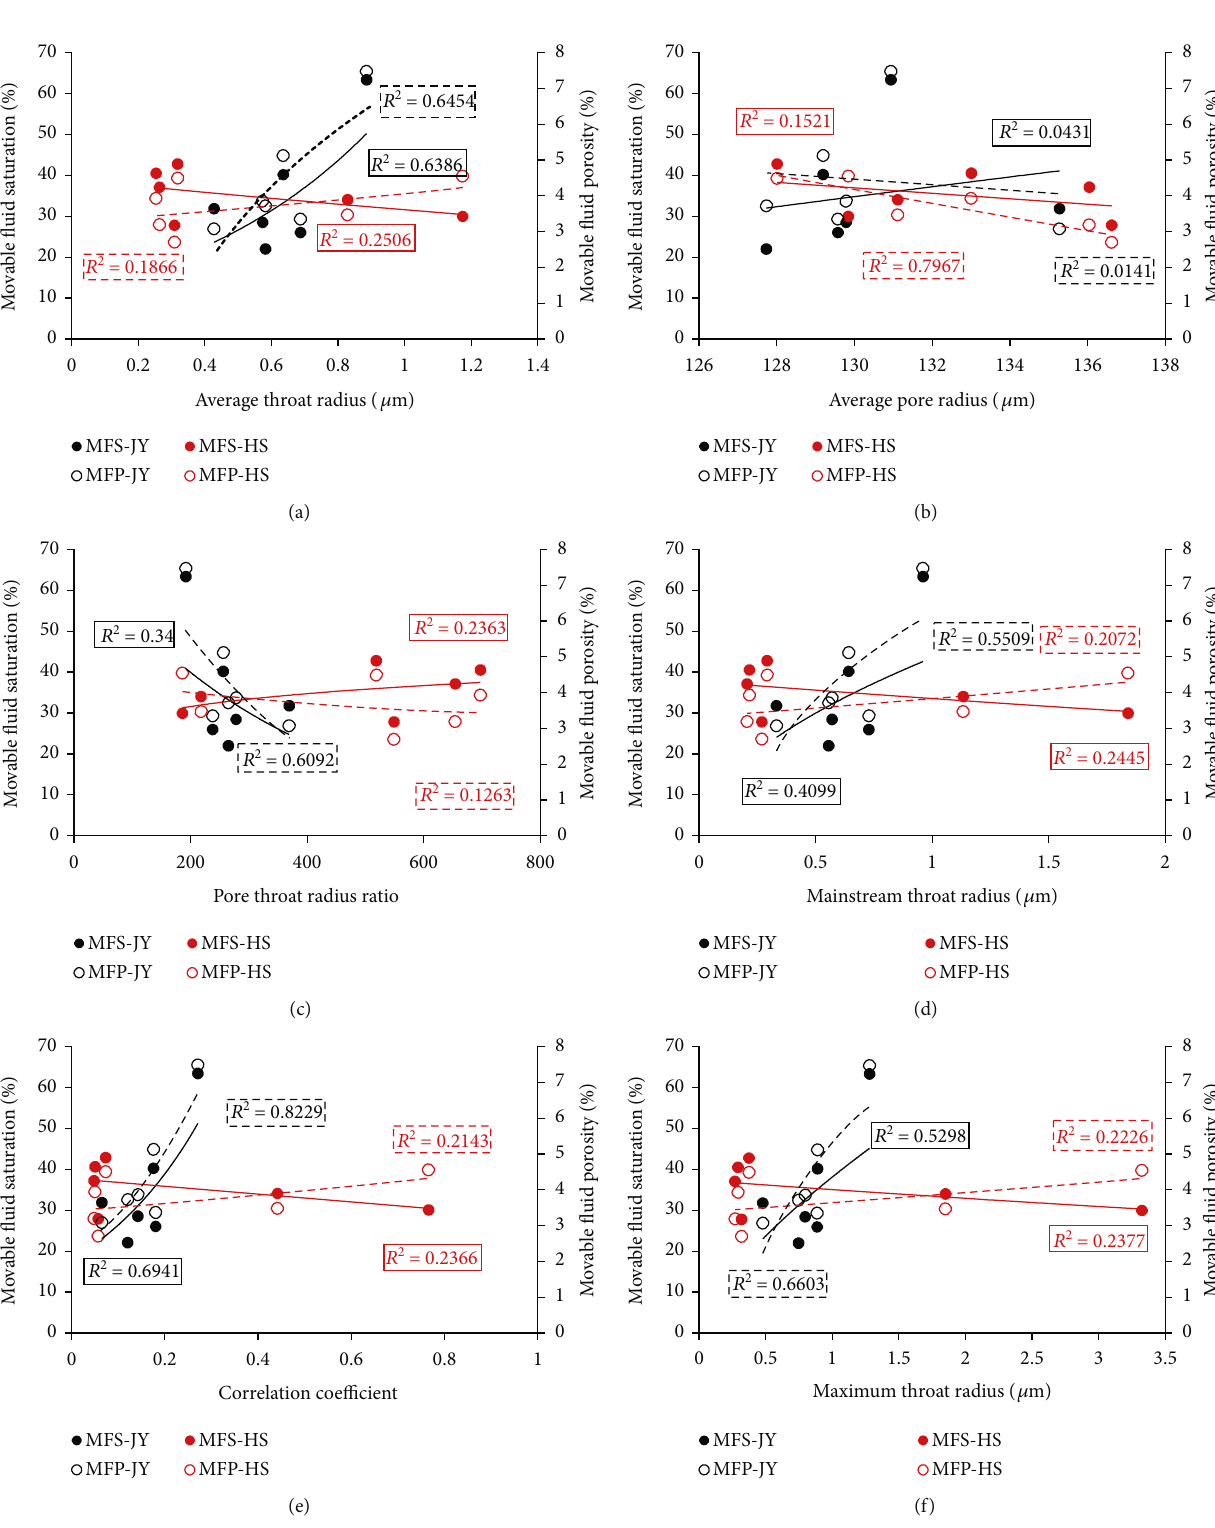
Figure 11: Relationship between pore structure-related properties and movable fl uid parameters. MFS-JY: movable fl uid saturation in Jiyuan; MFP-JY: movable fl uid porosity in Jiyuan; MFS-HS: movable fl uid saturation in Heshui; MFP-HS: movable fl uid porosity in